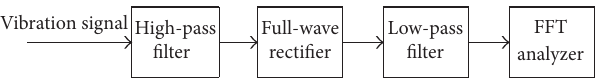
Figure 2: Sketch of envelope detection method